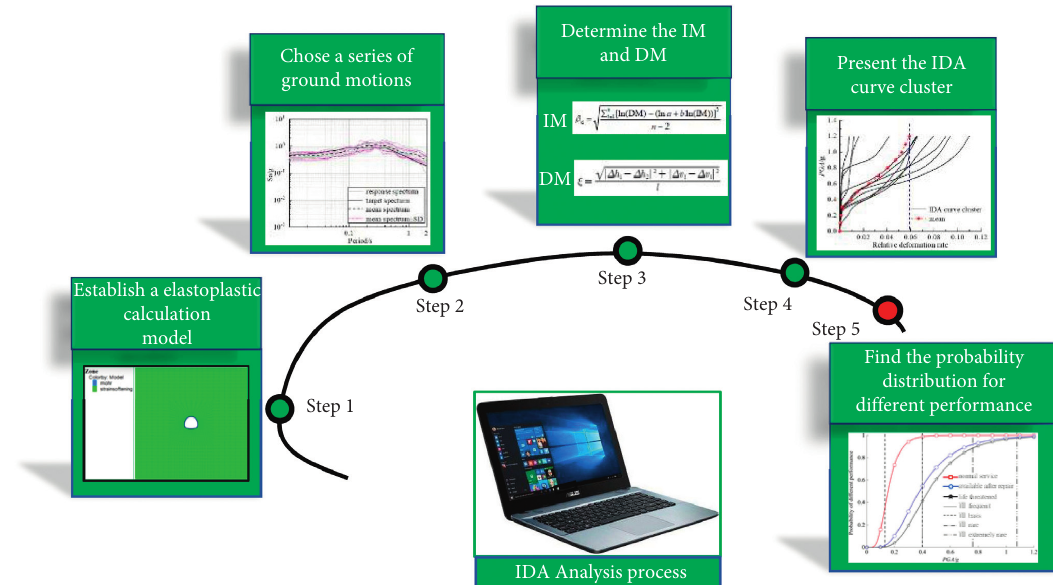
Figure 6: The specific analysis process of IDA.